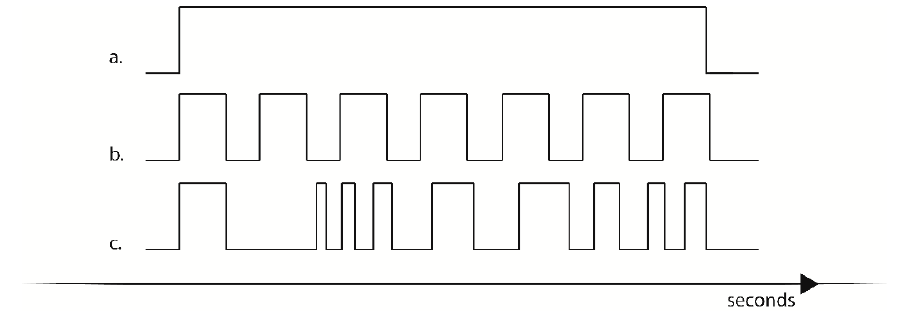
Figure 3. Examples of programmable stimulation. ( a ) Continuous stimulation, ( b ) low variance stimulation, ( c ) high variance stimulation.